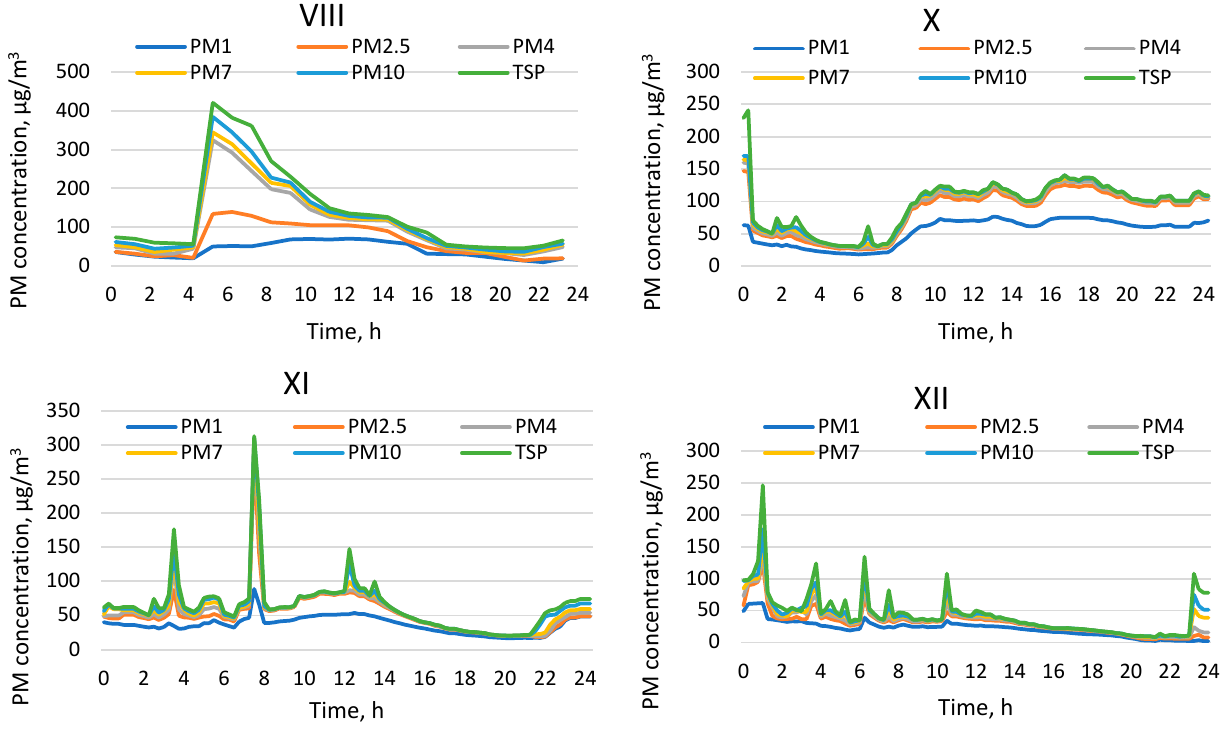
Figure 1. The hourly average concentrations of particulate matter in the air of the fire brigade unit in Poland in the analyzed periods: August, October, November and December (VIII, X, XI, XII) 2021.